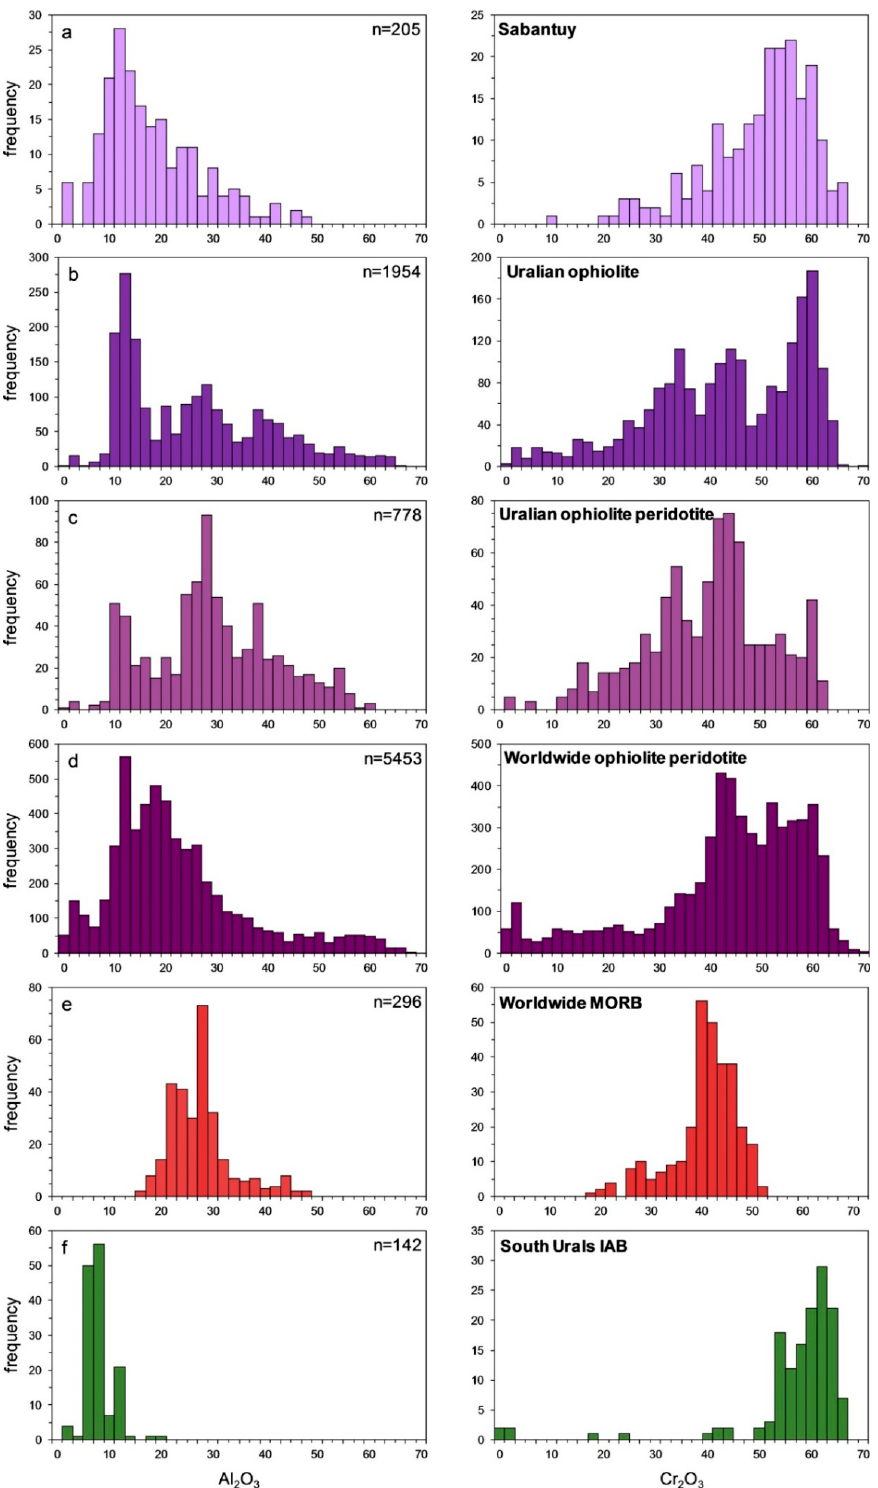
Figure 17. Histograms of Al 2 O 3 and Cr 2 O 3 frequency distribution for chromspinels from Sabantuy paleoplacer ( a ) (this study), Uralian ophiolite without chromitites ( b ) and ophiolite peridotite complexes, including chromite ores ( c ) [29,34,46,60,61], worldwide ophiolite complexes, including chromite ores ( d ) [42], MORB ( e ) [42] and Uralian island-arc basalts ( f ) ([53–56] and our unpub- lished